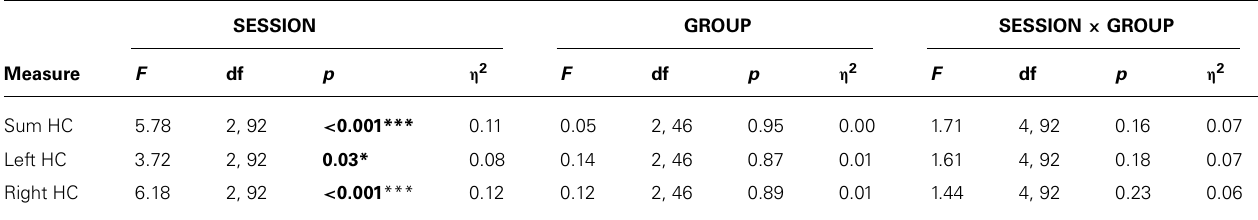
Table 5 | Statistics for repeated measureANOVA with main effects SESSION ( t 1, t 2, t 3) and GROUP (cardiovascular training, coordination training, control group) and interaction SESSION × GROUP for hippocampal (HC) volume (sum HC: sum of left and right volume, left HC volume, right HC volume).